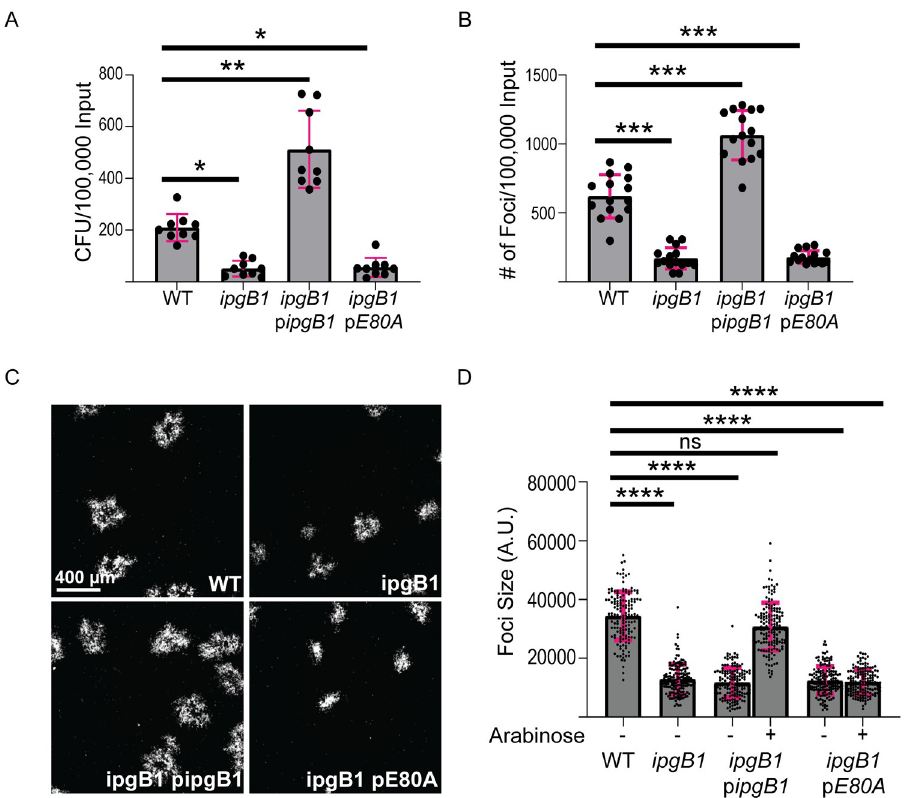
Fig 1. IpgB1 is required for efficient invasion and cell-to-cell spread in HT-29 cells. (A) Intracellular CFUs from HT-29 cells at 2 hr postinfection normalized to inoculum. Three independent biological replicates were performed, each containing three technical replicates. Each point represents one technical replicate and the grey bars represent the mean number of CFU. (B) Number of infection foci formed at 8 hr postinfection normalized to inoculum. Three independent biological replicates were performed, each containing five technical replicates. Each point represents one technical replicate and the grey bars represent the mean number of foci. For ipgB1 p ipgB1 and ipgB1 p E80A , arabinose was added at a final concentration of 0.5% during exponential growth and invasion. (C) Representative images showing infection foci formed in HT-29 cells at 16 hr postinfection. The scale bar is 400 μ m. (D) Quantification of foci size (area) in arbitrary units at 16 hr postinfection. Three independent biological replicates were performed, each containing at least 50 foci. Each point represents one focus and the grey bars represent the mean foci size. For ipgB1 p ipgB1 and ipgB1 p E80A , arabinose was added at a final concentration of 1% at 1 hr postinfection. Error bars represent the standard deviations; one-way ANOVA was performed with Dunnett’s multiple comparisons test; ns, not significant; � , p < 0.05; �� , p < 0.005; ��� , p < 0.001; ���� , p <